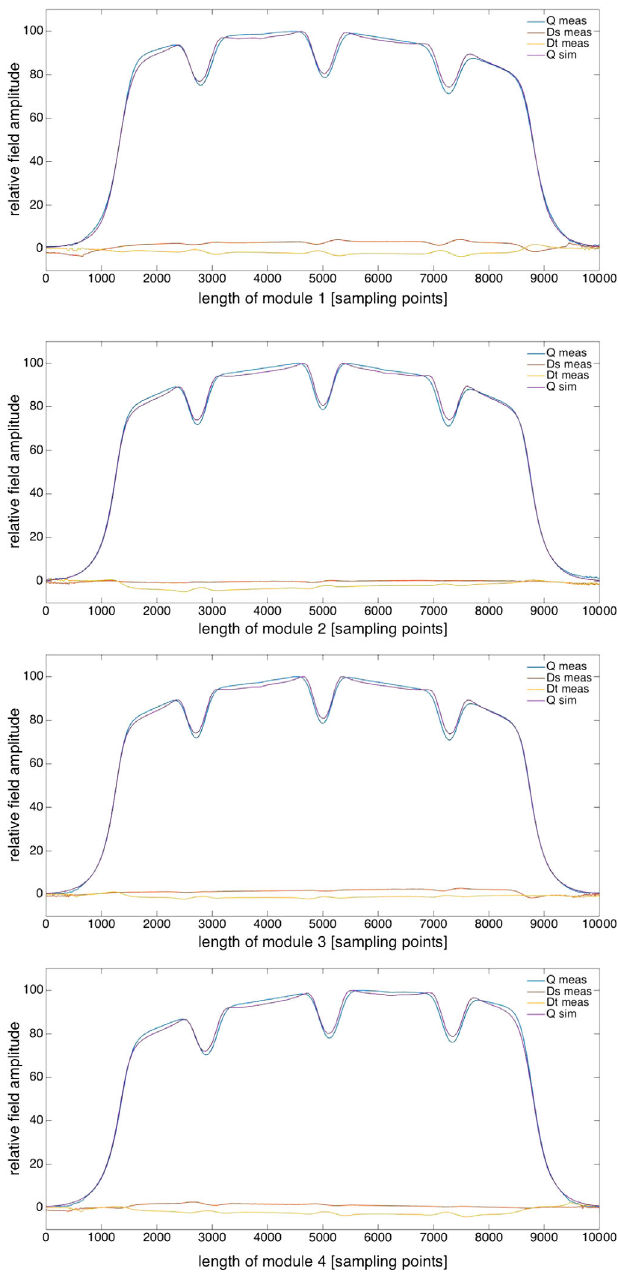
FIG. 7. From top to bottom module 1 to 4. The plots show the comparison of measured Q, Ds and Dt components with simulation of the Q component. In simulations the Ds and Dt vanish